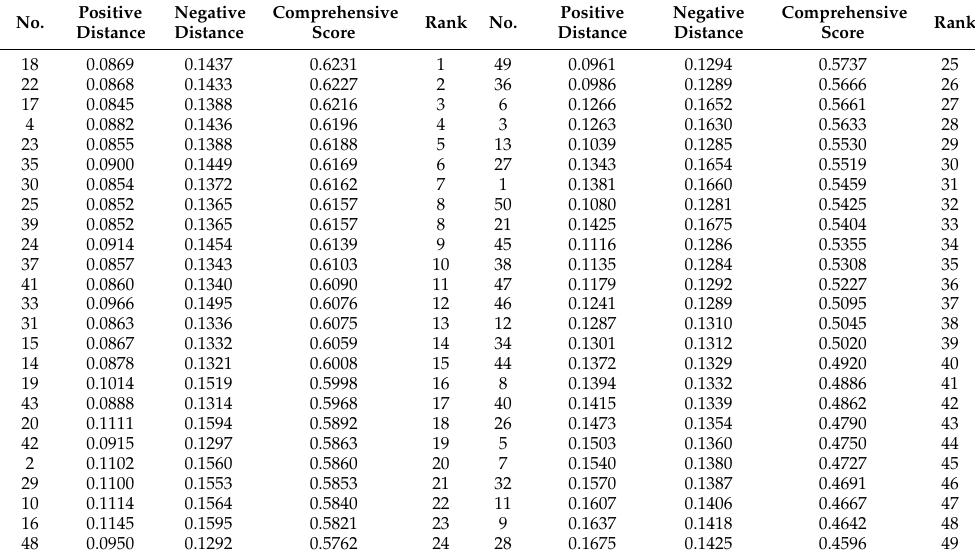
Table 6. Results of TOPSIS method